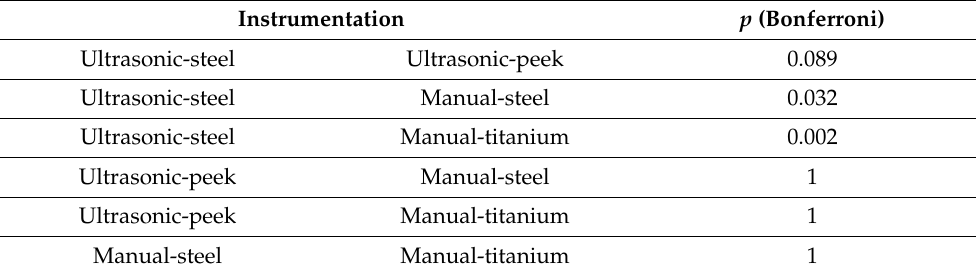
Table 3. Bonferroni